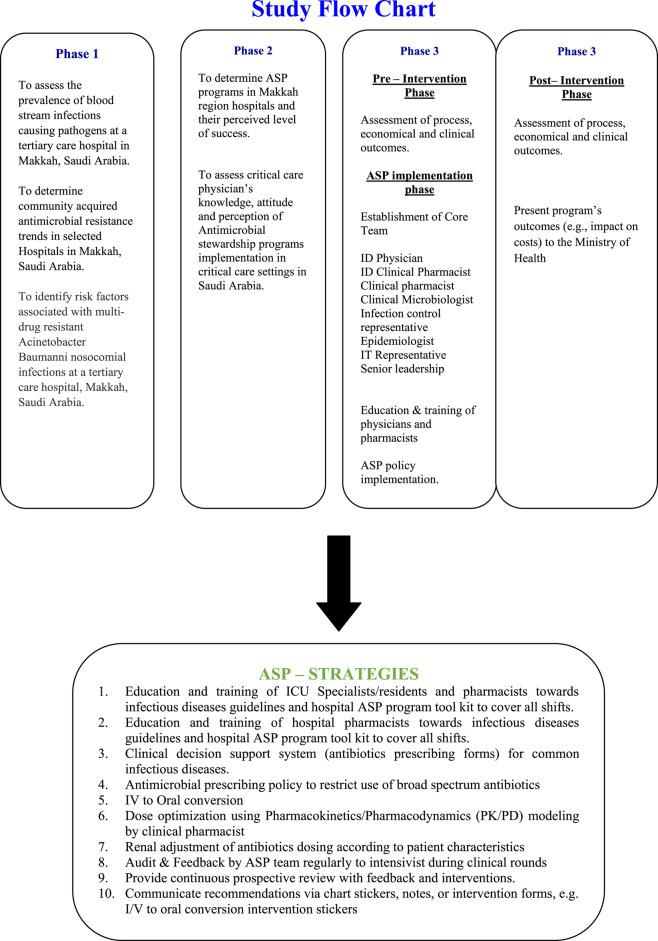
Study flow chart.